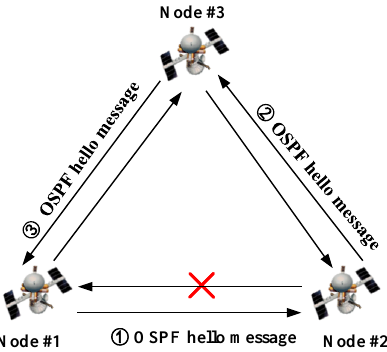
Figure 11. The principle of uni-directional OSPF